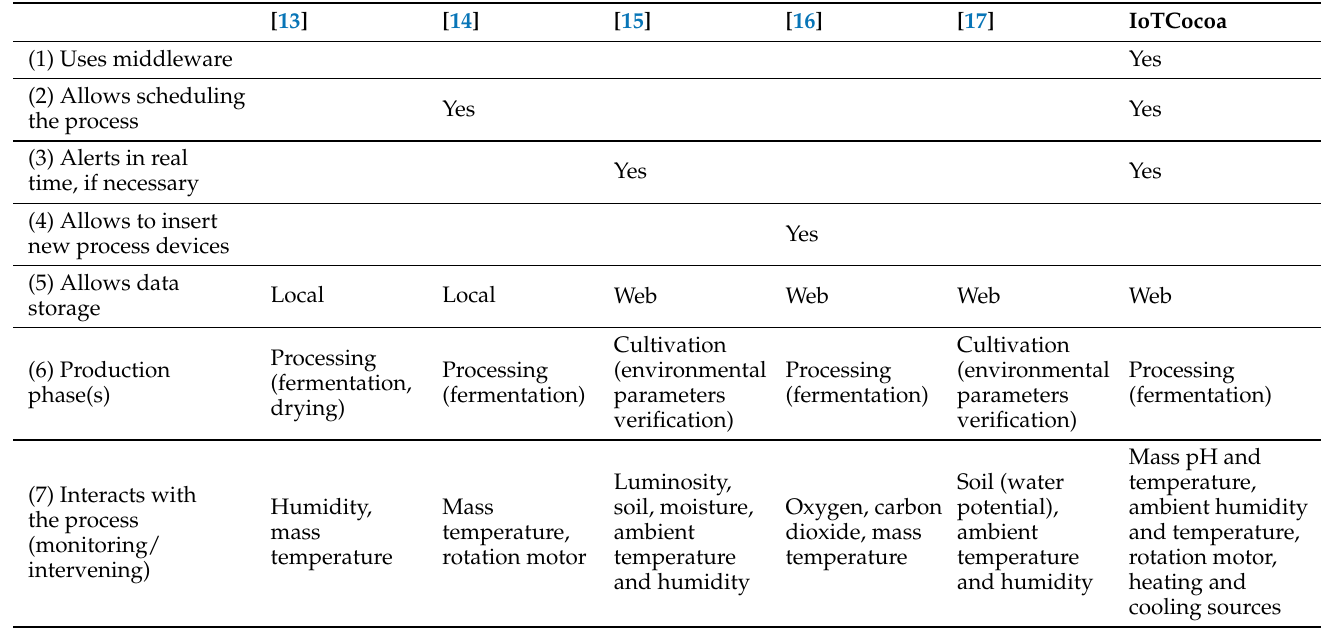
Table 1. Comparison between IoTCocoa and other cocoa IoT-based